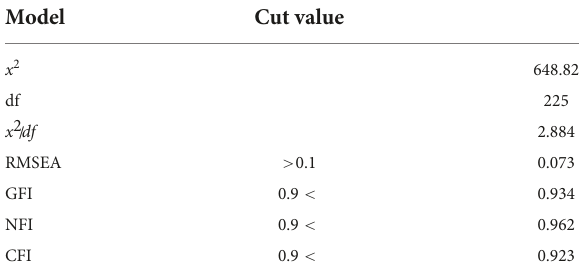
TABLE 4 Fit indices (model 2).